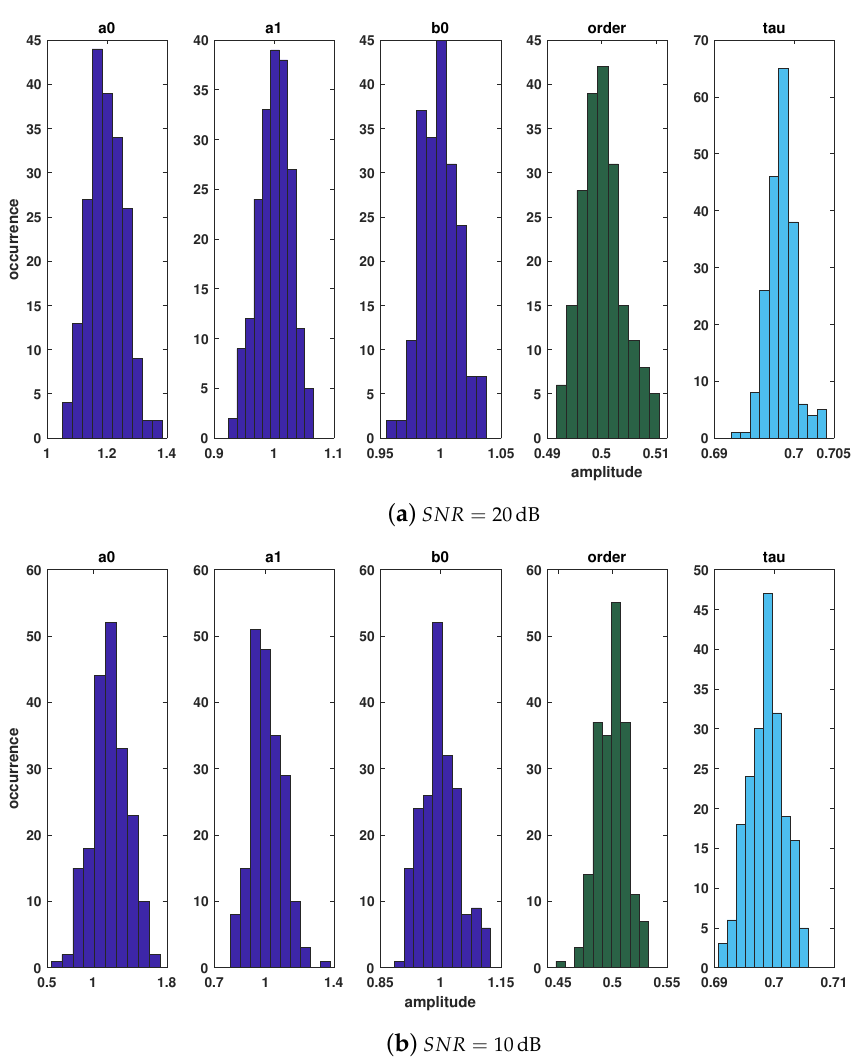
Figure 10. The histograms of the process estimates of example 2 with the FSTD - OE algorithm SNR y = 20 [dB] nmc =